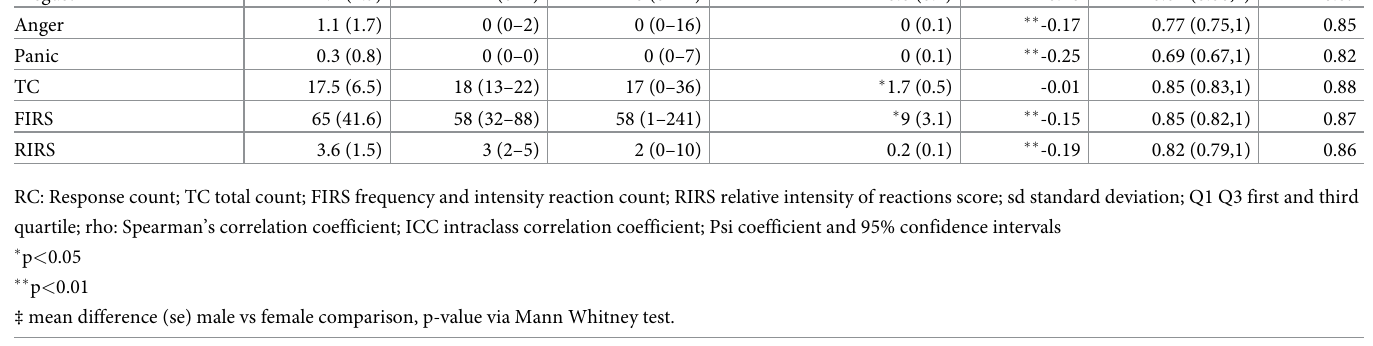
RC: Response count; TC total count; FIRS frequency and intensity reaction count; RIRS relative intensity of reactions score; sd standard deviation; Q1 Q3 first and third quartile; rho: Spearman’s correlation coefficient; ICC intraclass correlation coefficient; Psi coefficient and 95% confidence intervals � p < 0.05 �� p <